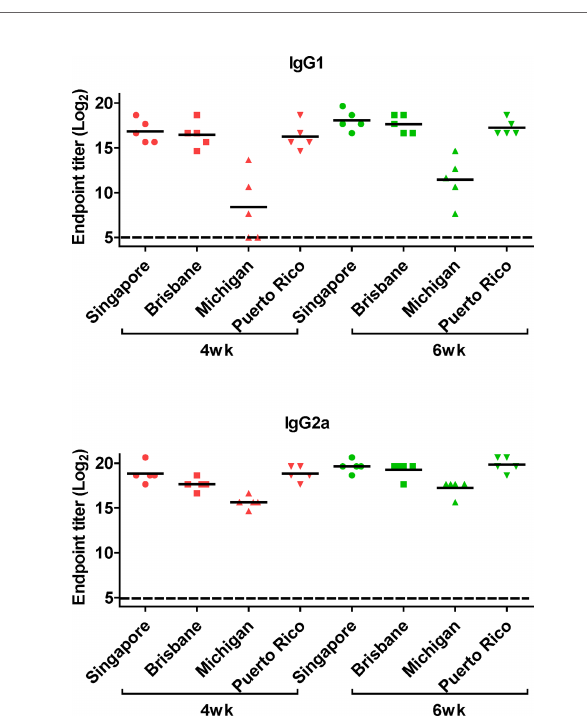
FIGURE 6 | Generation of cross-protective reactive antibodies against the whole hemagglutinin (HA) protein of recombinant H1 strain. HA proteins of H1 strain-speci fi c IgG1 and IgG2a were detected ELISA. Two-fold serial diluted mice sera collected at 4 or 6 weeks posy-vaccination were bound to HA proteins of A/Singapore/Gp1908/15, A/Brisbane/59/07, A/Michigan/45/15, and A/Puerto Rico/8/34. The graph shows the endpoint (E.P) of each cohort (N=5). E.P means the reciprocal serum dilution of the vaccinated group that yielded OD 450 greater than the mean + 2SD of the PBS-treated group.